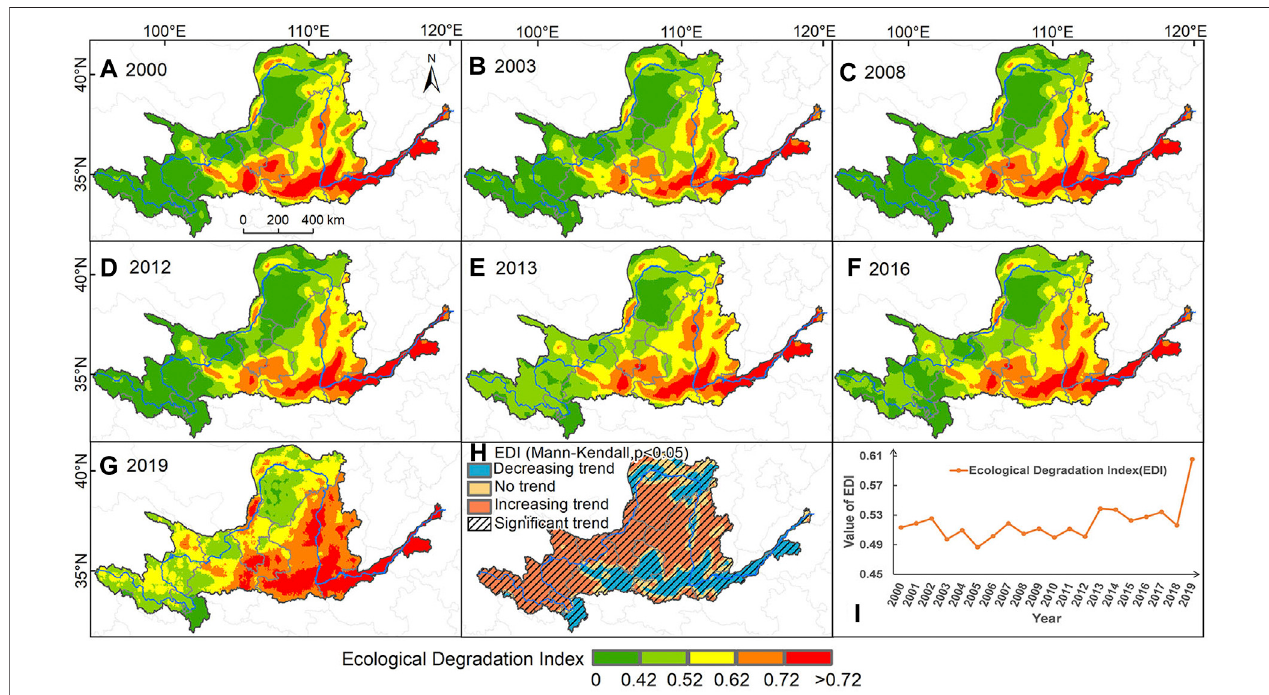
FIGURE5| Spatial distribution ofecologicaldegradation indexEDI in2000,2003, 2008,2012,2013, 2016and 2019 (A – G) ,Mann-Kendalltest results atthe 0.05 signi fi cance level of EDI (H) , and the trend of ecological degradation index over time (I) .